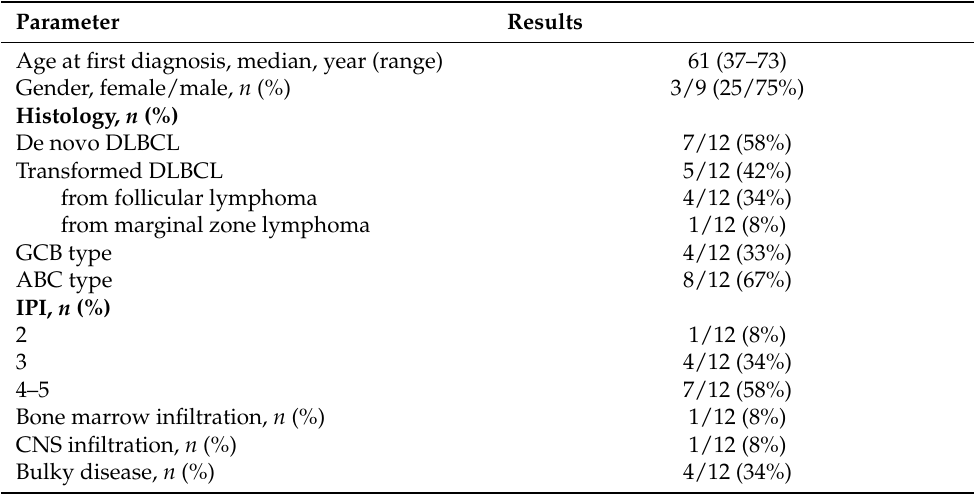
Table 1. Patient characteristics and previous